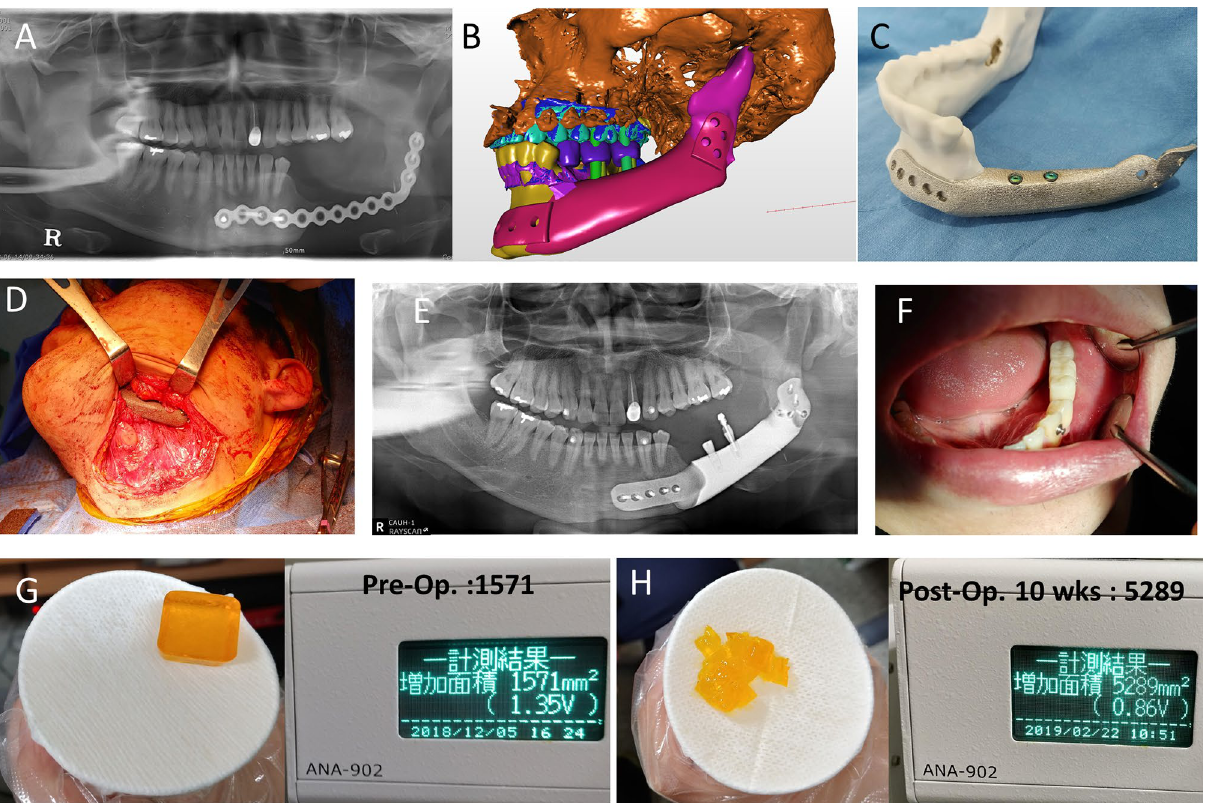
Figure 2. Dental implant on a titanium mandible. ( A ) Initial panoramic radiography of the patient (27/M); s/p ameloblastoma resection and fibula free flap failed. ( B ) To restore the patient’s masticatory function, two holes were designed to place dental implants. ( C ) Two Osstem implants were placed in the titanium mandible; ( D ) A titanium three-dimensional printed mandibular implant with a prefabricated dental implant was placed under general anesthesia. ( E ) The second implant surgery was performed 6 weeks postoperatively. ( F ) Prosthetic treatment was performed using a custom abutment and temporary crowns. ( G , H ) The yellow jelly was chewed 30 times by the patient, and the surface area was measured to see how well the jelly was chewed. The mastication efficiency measured after surgery increased three-fold compared with that before Non‑segmental mandibular defect reconstruction. A 25-year-old man (No. 11) with hemifacial macrosomia was classified as having Pruzanksky type I mandibular deformity. The patient did not experience any hearing problems. However, the patient had mild hypoplasia of the right ramus and flattening of the condyle and gle- noid fossa. The mandible was retrusive, and there was a large discrepancy in the bone volume between the left and right mandibular angles. As the patient had accompanying skeletal malocclusion, unilateral mandibular angle augmentation with a 3D-printed titanium implant was performed by orthognathic surgery. A 36-year-old man (No. 12), who underwent resection of both mandibular angles at a local clinic, had facial asymmetry. The left mandibular angle was over-resected compared to the opposite side. Left-sided angle reconstruction was performed using a titanium implant. Another 31-year-old man underwent a genioplasty at a local clinic as he wanted to restore the jaw length. Chin augmentation with two-piece titanium chin implants was performed (Fig. 4A–D).